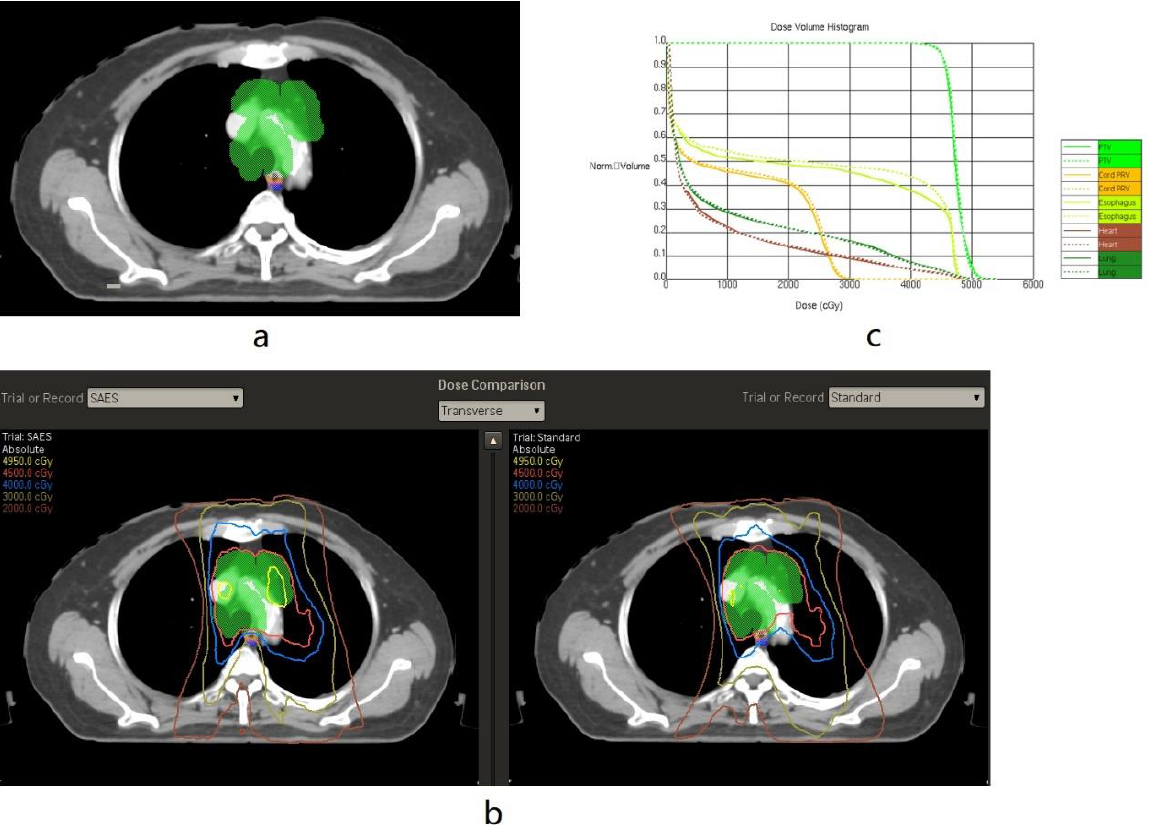
Figure 2. Illustrating the segmental abutting esophagus-sparing (SAES) technique applied in left- side tumour (Axial CT Images). ( a ): Examples of the planning target volume (green), involved esophagus (IE, white), abutting esophagus1 (AE1, orange), AE2 (light purple), and AE3 (shaded blue). ( b ): Examples of isodose line distributions showing effective AE-sparing sparing in the SAES plan compared to the standard (non-SAES) plan. In the SAES plan, isodose lines of 4000 and 4500 cGy were set to avoid AE1–3, and an isodose line of 3000 cGy was set to avoid AE3. ( c ) Examples of the dose-volume histogram (DVH) showing a reduced volume of the esophagus receiving 25–45 Gy in the SAES plan (solid line) compared with the standard plan (dotted